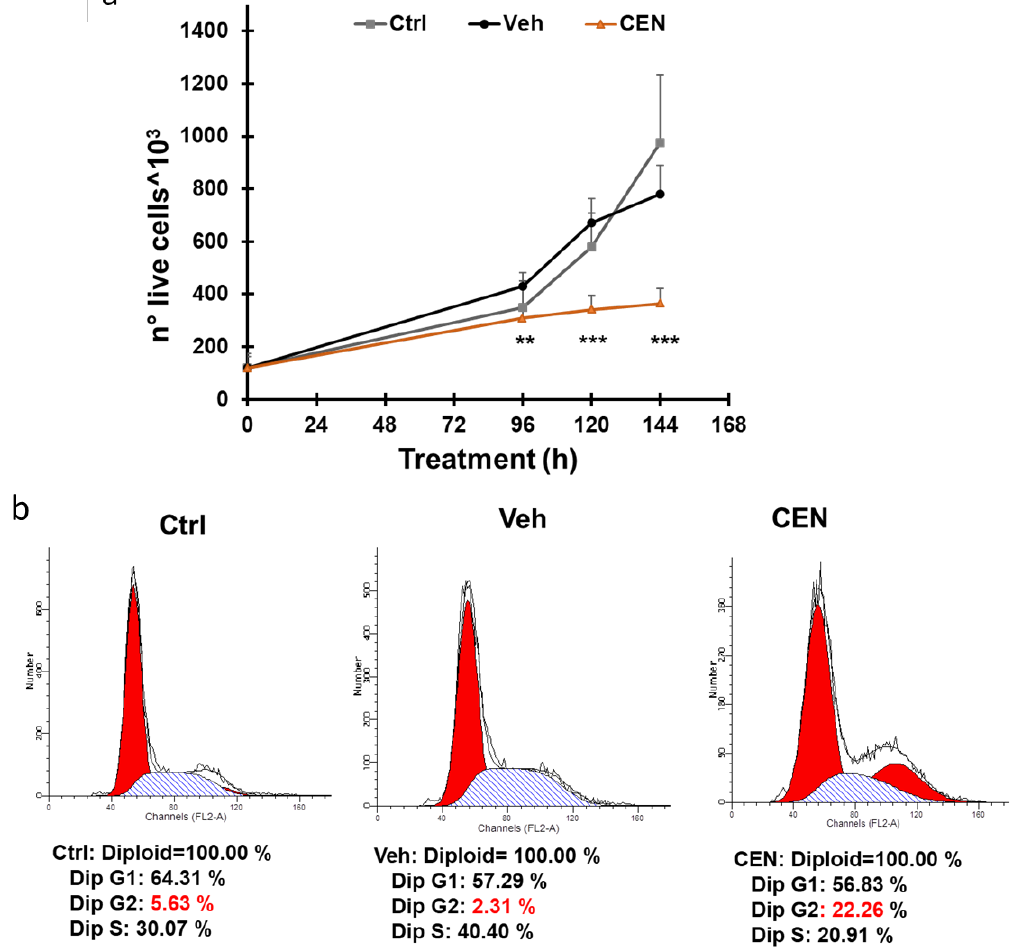
Figure 2. CEN arrested the proliferation of SAOS400 cells in the G2/M phase of the cell cycle. Panel ( a ): Cells were treated with CEN (200 µ g/mL) and counted at the indicated times using Trypan blue stain, as described in the Methods Section. The line graphs represent the mean of three experiments (±SD). Symbols indicate significance: ** p < 0.01 and *** p < 0.001, with respect to untreated (Ctrl) and vehicle (Veh). Panel ( b ): Cells were fixed and stained with propidium iodide for cytofluorimetric analysis, as described. DNA content analyses obtained with ModFit software 3.0 are shown after 144 h of incubation in untreated (Ctrl), vehicle (Veh), or CEN-treated cells.